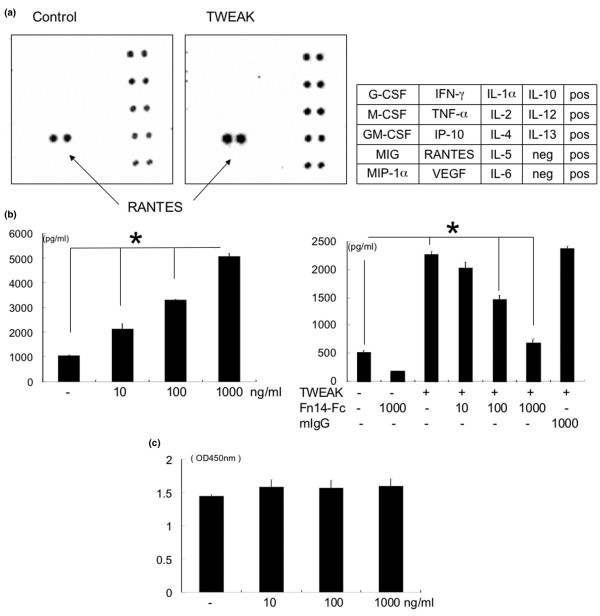
TWEAK/Fn14 interaction induces RANTES production by MC3T3-E1 cells. (a) MC3T3-E1 cells were cultured in the presence or absence of 100 ng/ml TWEAK for 48 hours. The culture supernatants were then collected and subjected to a cytokine protein array. The table indicates the corresponding cytokines on the protein array membrane. (b) MC3T3-E1 cells were stimulated with the indicated doses of TWEAK for 48 hours in the presence or absence of the indicated doses (ng/ml) of mouse Fn14-Fc chimera or control mouse immunoglobulin G (mIgG). The culture supernatants were then collected, and the RANTES concentrations were measured by enzyme-linked immunosorbent assay. (c) MC3T3-E1 cells were stimulated with the indicated doses of TWEAK for 96 hours. Viable cell number was then measured by WST assay. The data were expressed as OD units. Values represent the mean ± standard deviation. *p < 0.05 compared with corresponding control. Similar results were obtained in at least three independent experiments. Fn14, fibroblast growth factor-inducible 14; G-CSF, granulocyte-cell-stimulating factor; GM-CSF, granulocyte macrophage-colony-stimulating factor; IFN-γ, interferon-γ; IL, interleukin; IP-10, inositol phosphate-10; M-CSF, macrophage-colony-stimulating factor; MIG, monokine induced by IFN-γ; MIP-1α, viral macrophage inflammatory protein-1α; OD, optical density; RANTES, regulated upon activation, healthy T cell expressed and secreted; TNF-α, tumour necrosis factor-α; TWEAK, tumour necrosis factor-like weak inducer of apoptosis; VEGF, vascular endothelial growth factor; WST, water-soluble tetrazolium.